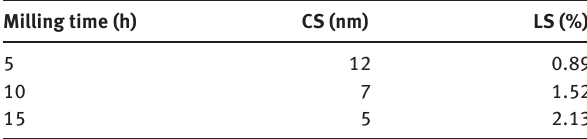
Table 1: Crystallite size (CS) and lattice strain (LS) of equiatomic AlMgNiCrTi high entropy alloy powder with milling